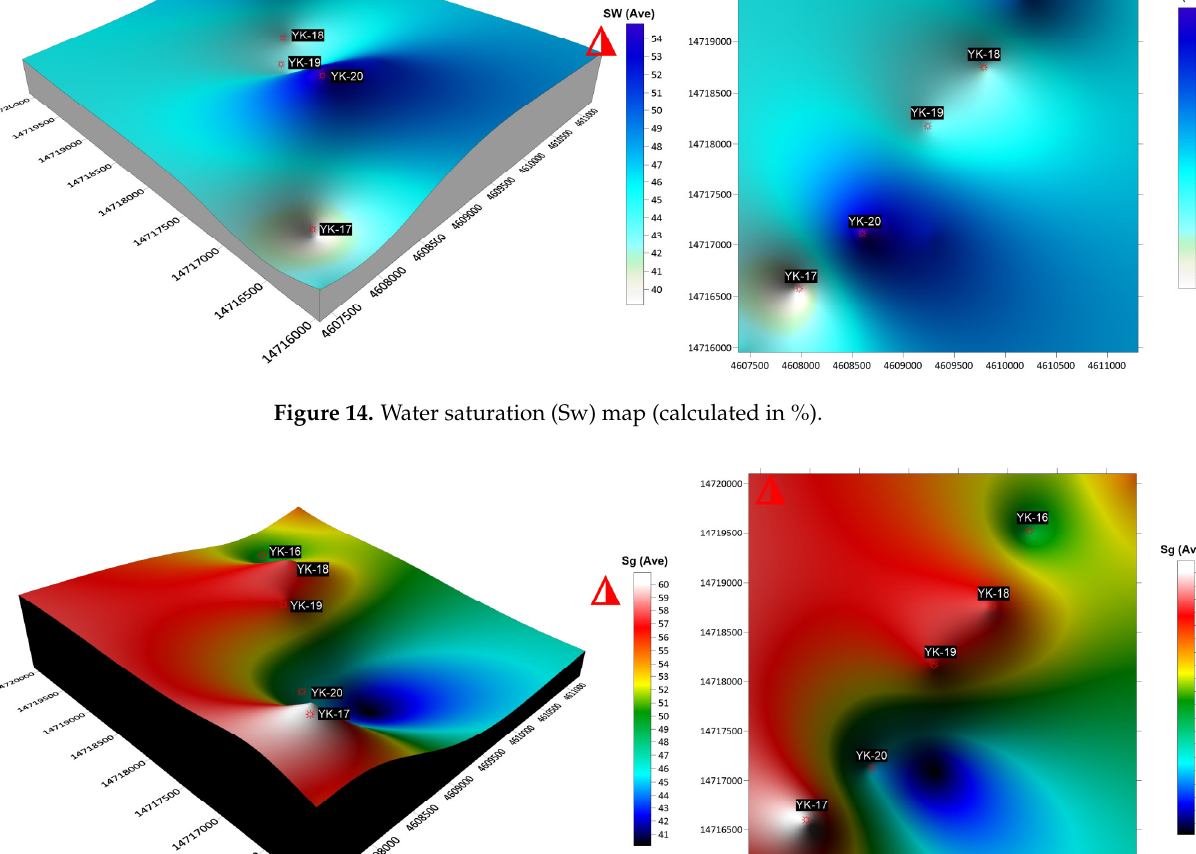
Figure 16. Permeability distribution map. Shale volumetric variation is an important clue for predicting the sand distribution in the study area. The lowest value of shale content is recorded at 16% in well YK16, while the highest content is detected at 23% in well YK20. A remarkable reduction in shale